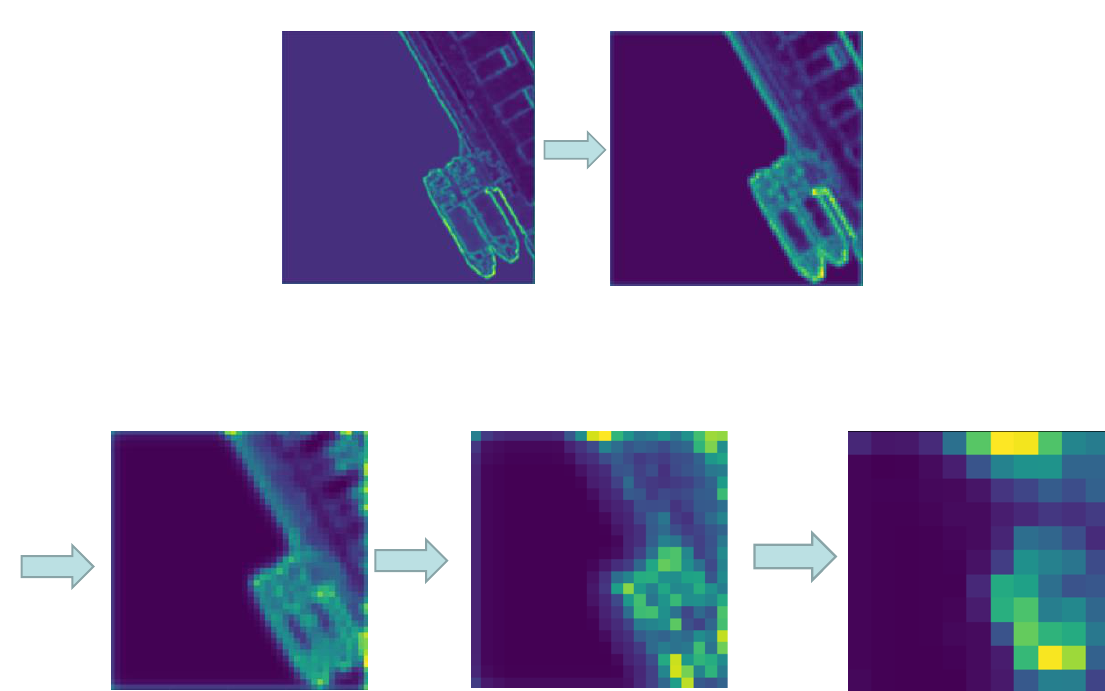
Figure 3. Multi scale visualization results of atrous spatial pyramid pooling (ASPP).